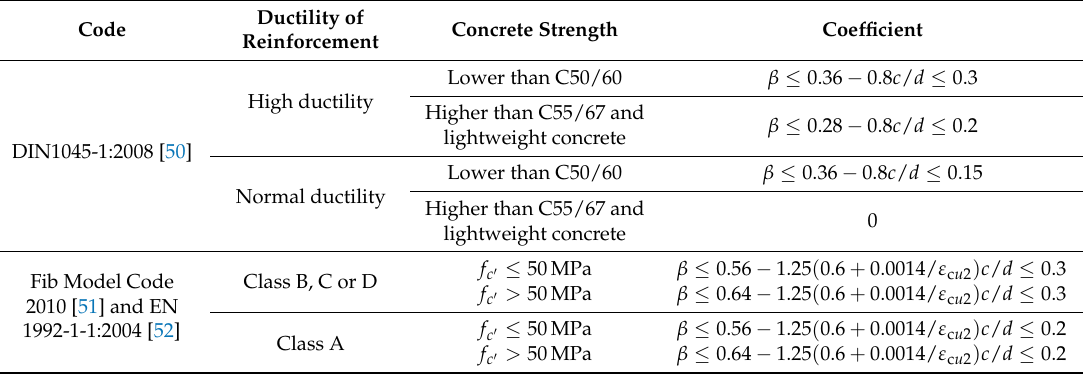
Table 8. Coefficient of moment redistribution in DIN1045-1:2008 [50], fib MC2010 [51] and EN 1992-1-1:2004